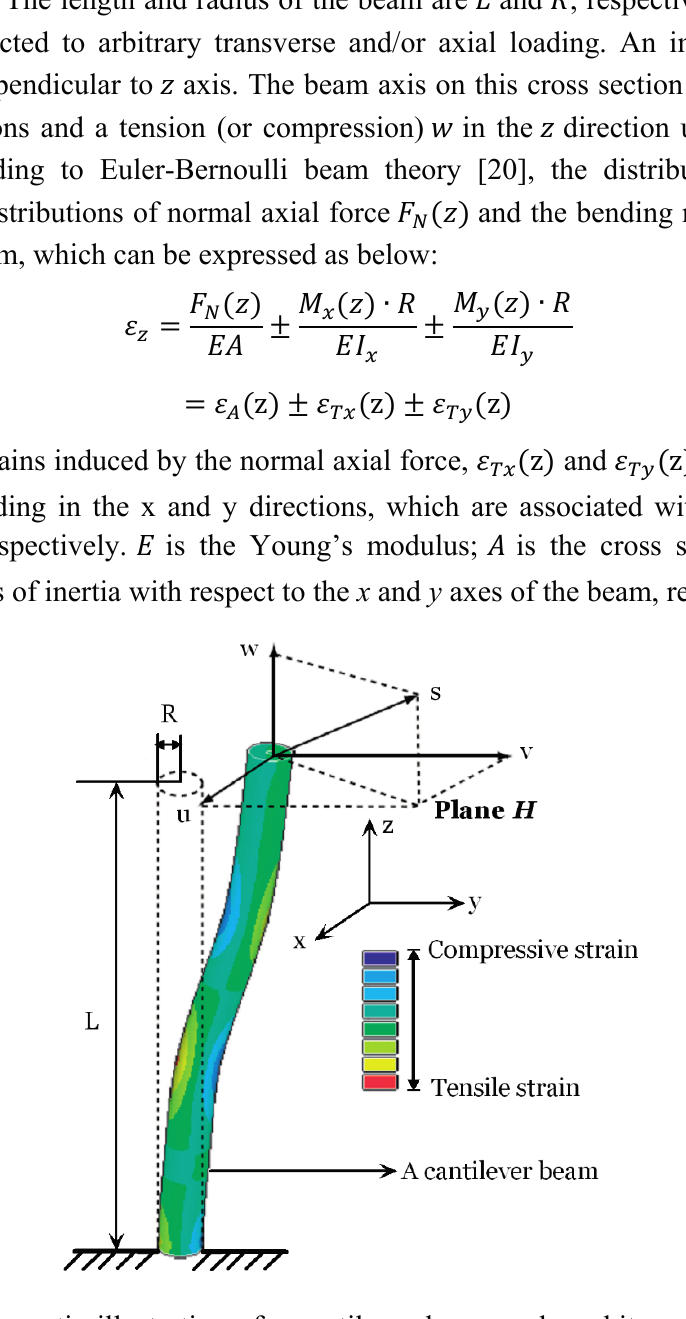
Figure 2. A schematic illustration of a cantilever beam under arbitrary transverse and/or axial